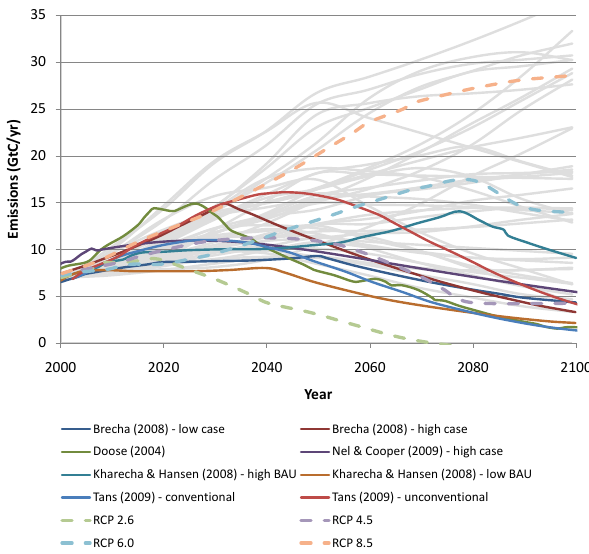
Fig. 3. Comparison between various projections for GHG emissions due to fossil fuel production and the six SRES marker scenarios presented in Nakicenovic and Swart